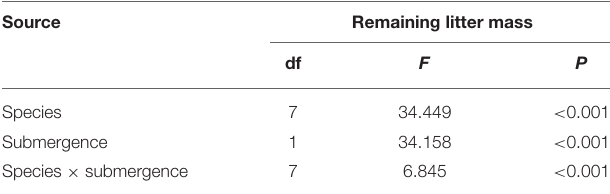
TABLE 4 | Two-way ANOVA results indicate the loss of litter mass of individual species in the riparian zone of the Three Gorges Reservoir in China.